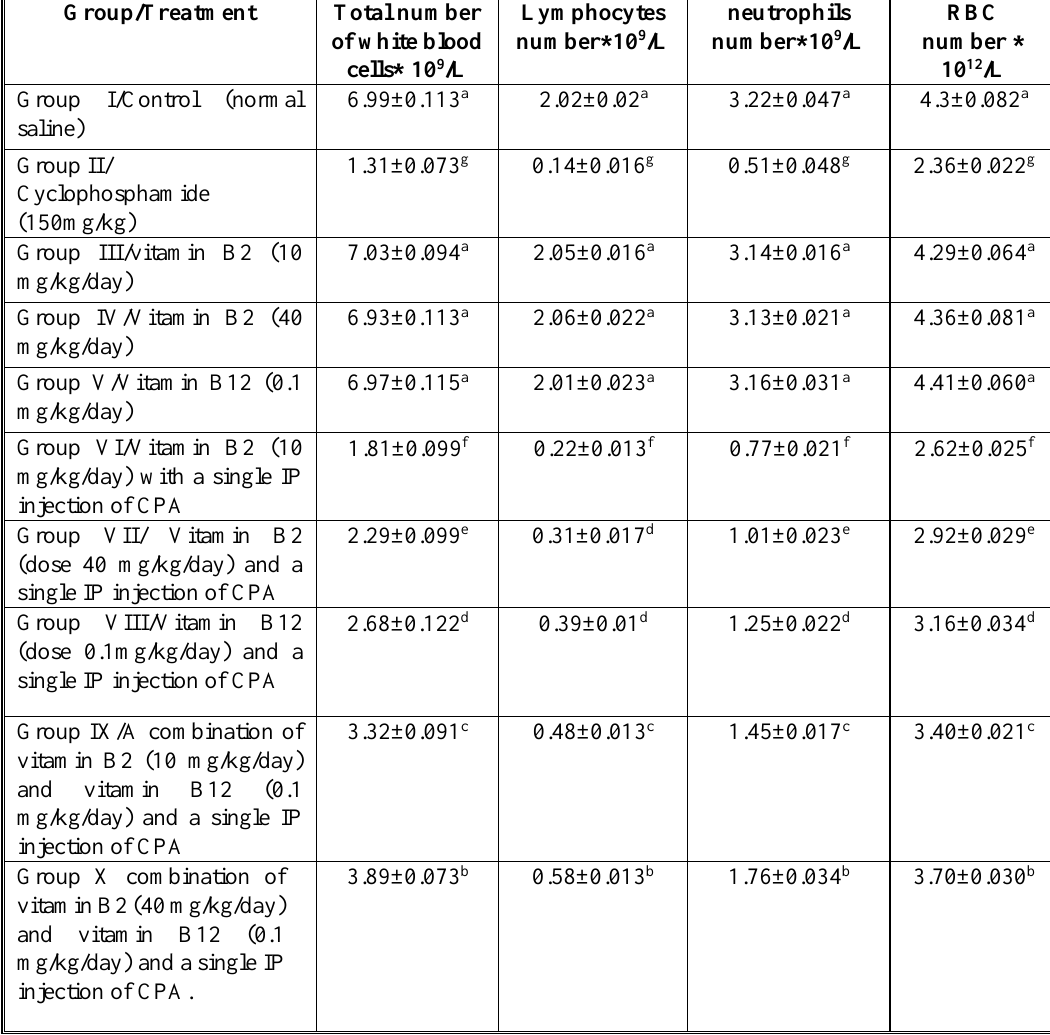
Table 1.Effects of different doses of vitamin B2 and single dose of vitamin B12 each alone and in combination on CBCs (total WBC, Lymphocytes, neutrophils and RBC) after IP injection of cyclophosphamide (CPA) in